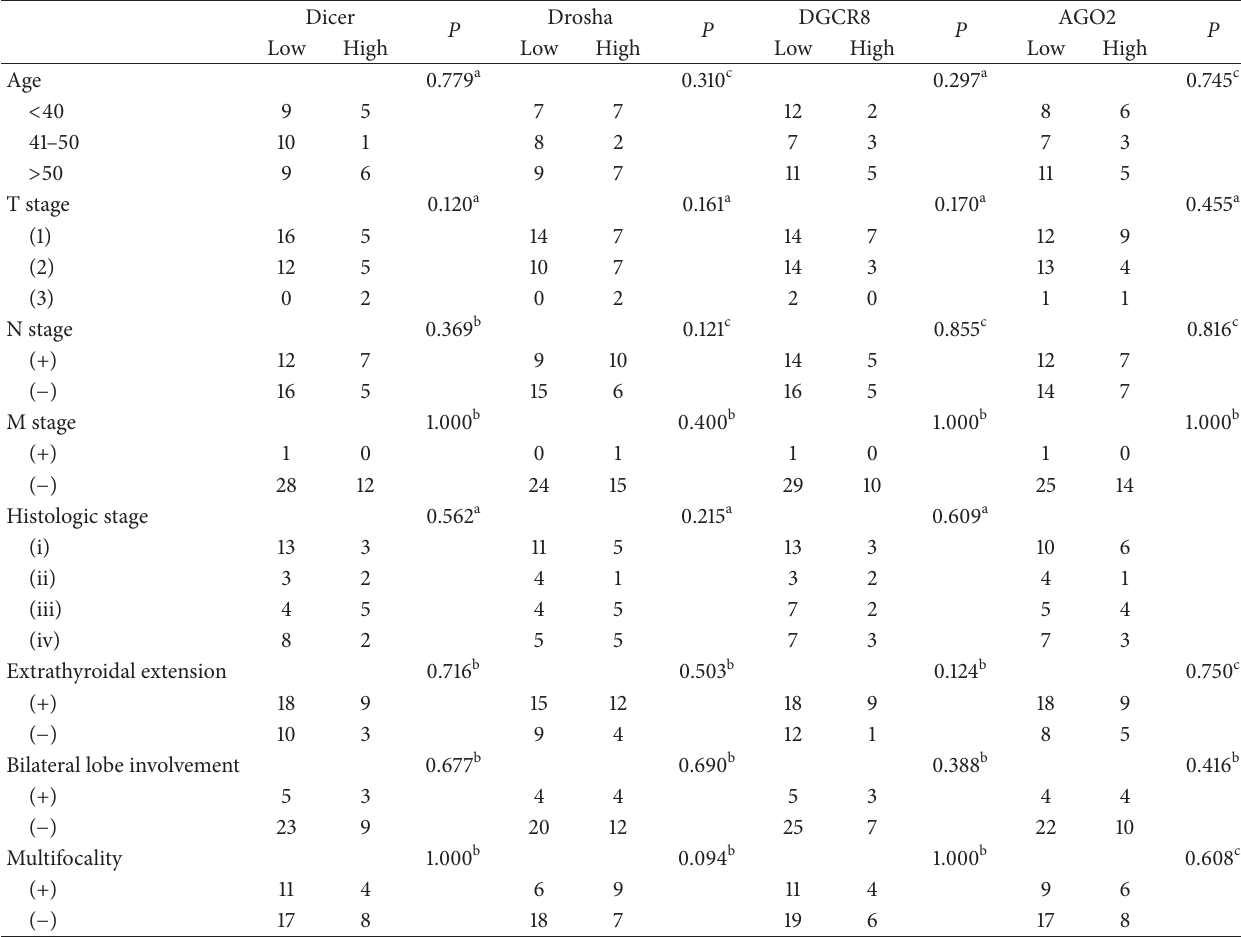
Table 2: Correlation of the clinicopathological parameters with Dicer, Drosha, AGO2, and DGCR8 mRNA expression levels in Asian Korean PTC